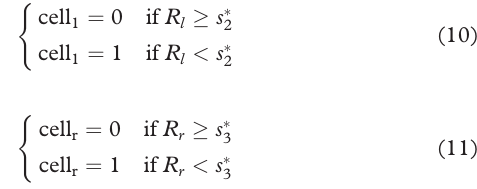
Depending on the occupancy state of cell grid, eight scenarios (four scenarios for LLC) can be generated, as depicted in Figure 3: (cid:1) LLC Scenario 0_0 : When the ego vehicle makes LLC, there are no object vehicles on both cell m and cell l ;